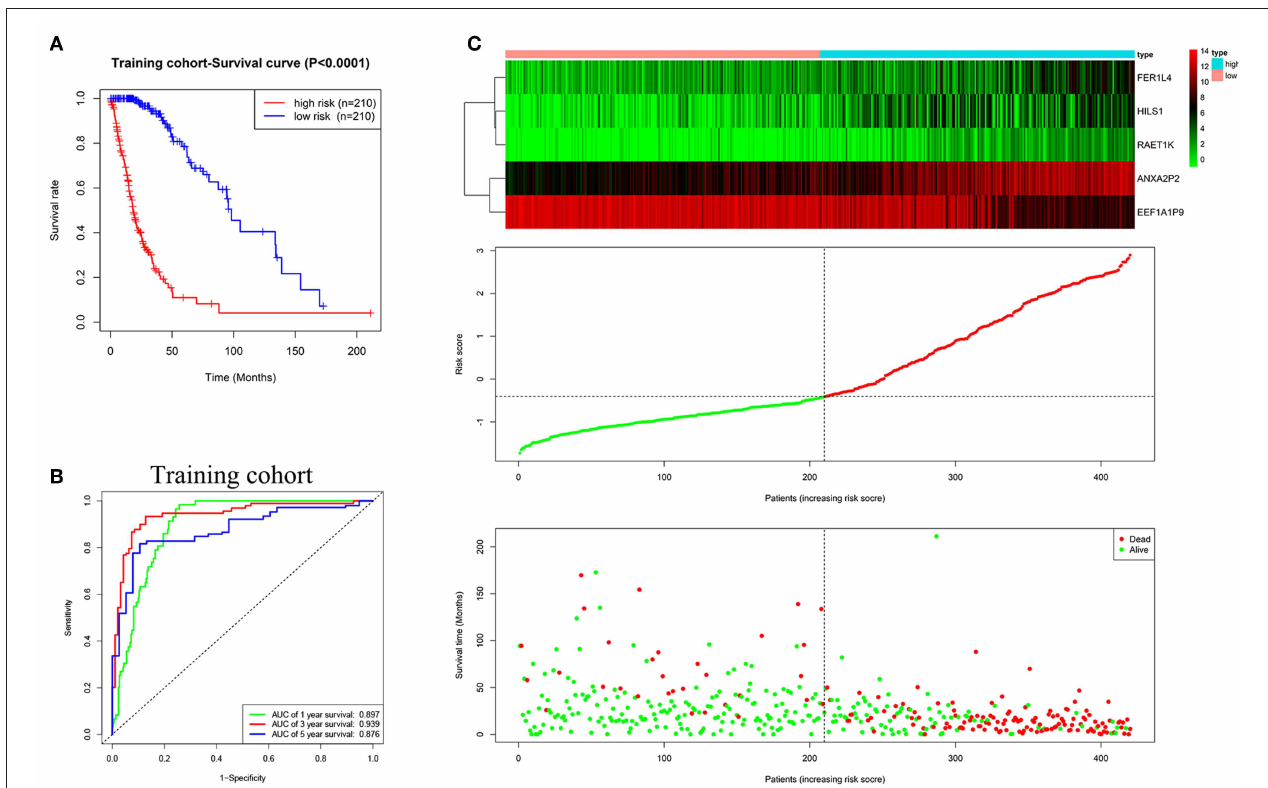
FIGURE 3 | Characteristics of the five-pseudogene risk signature in the training cohort. (A) Survival curves for high-risk and low-risk groups classified by the risk signature in the training cohort. (B) ROC curves for the 1-, 3-, and 5-year survival according to the five-pseudogene risk signature in the training cohort. (C) Glioma expression profiles of the five pseudogenes, risk score distributions and patient survival in the training